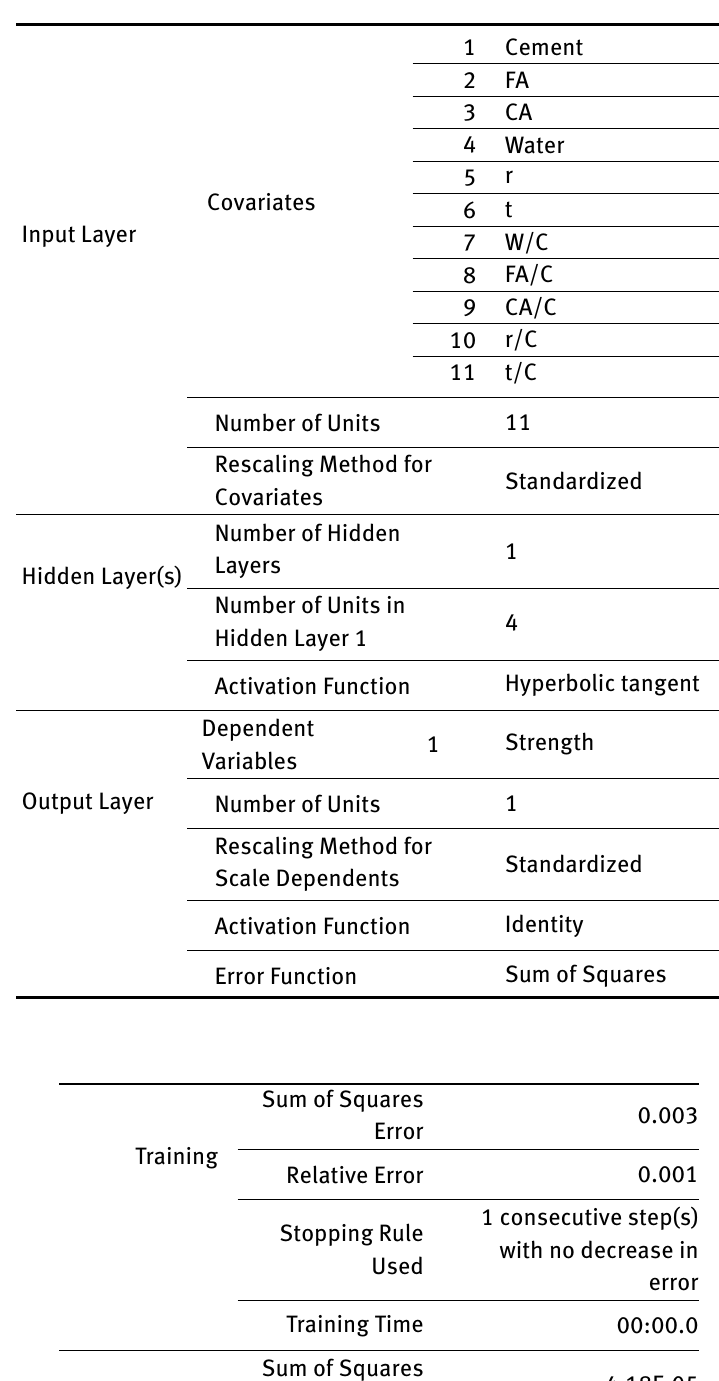
Table 5: Network Information